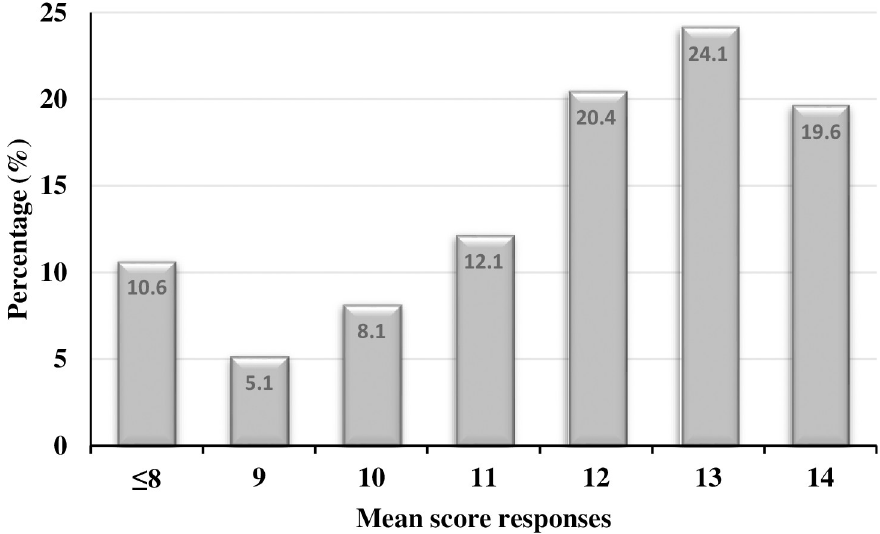
Fig 2. Mean score responses of respondents from 14 social and preventive practices of COVID-19, Addis Ababa, June 2020.